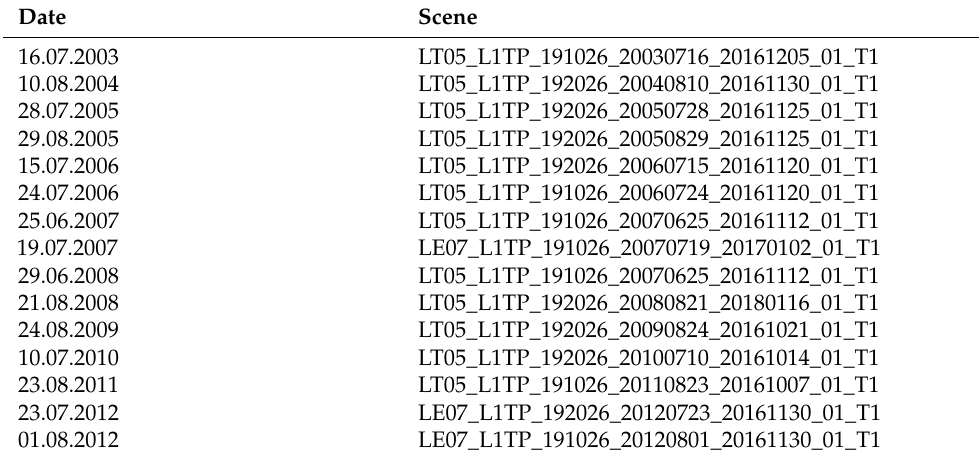
Table 2. LANDSAT scenes used for NDVI